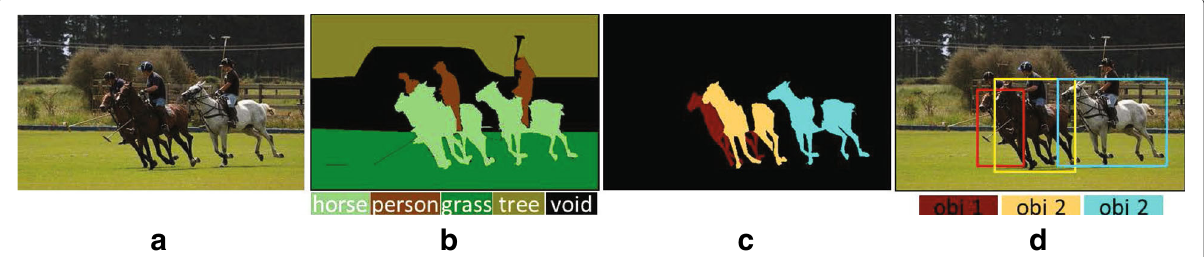
Fig. 4 Annotations of Polo. a The initial image, b the groundtruth labeling of categories, c the groundtruth labeling of instances, and d the bounding boxes of instances. Best viewed in